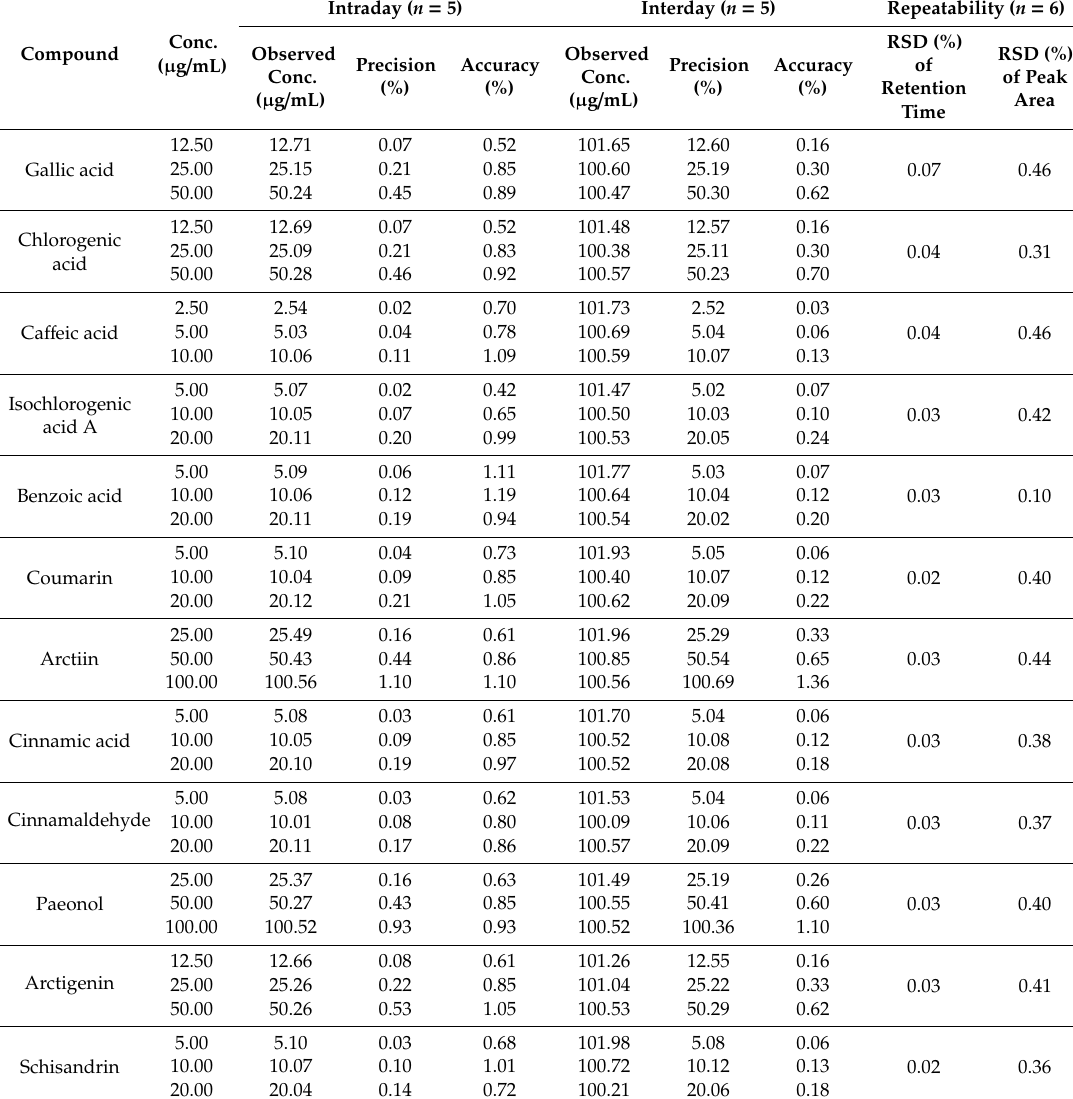
Table 4. Precision assay for 12 marker compounds in